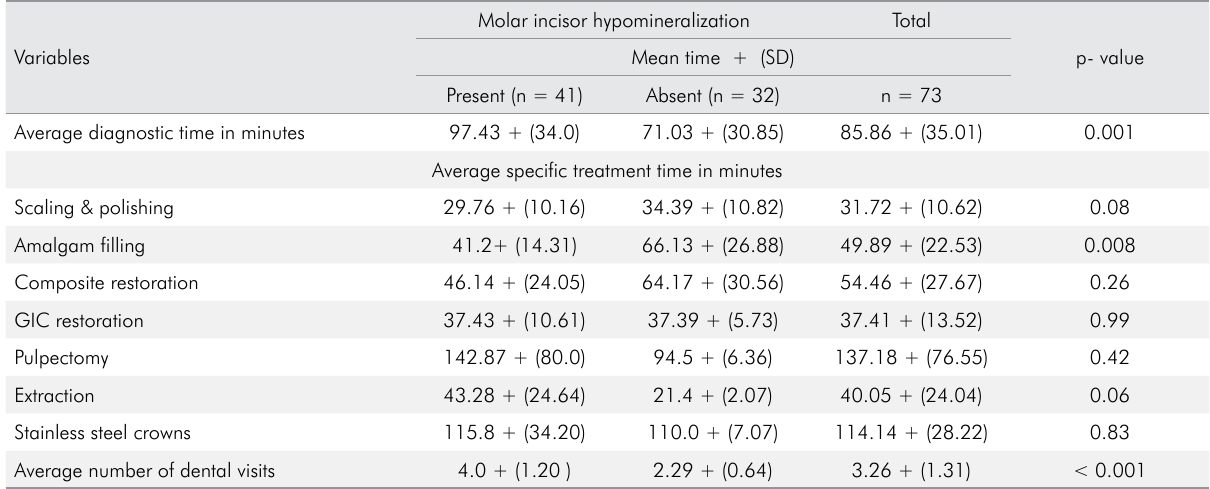
Table 2. Average clinical times and average number of dental visits for management of children with and without molar incisor hypomineralization.